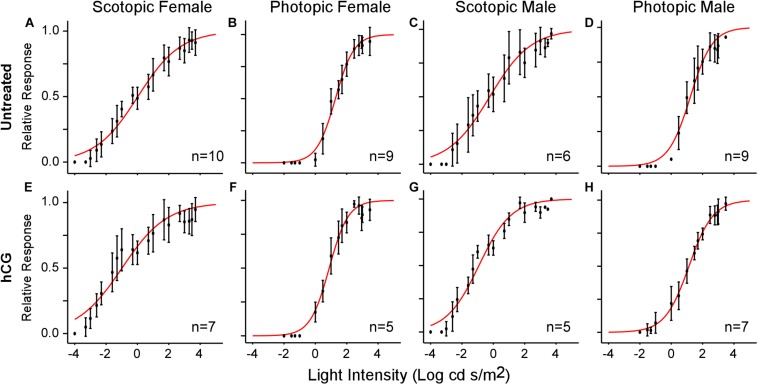
V-Log(I) curves showing mean ERG responses for each sex under scotopic and photopic conditions. Each point represents the mean (±SD) relative b-wave amplitude at each light intensity. Sample size (n) indicates the number of frogs used in each test. (A–D) V-Log(I) curves for untreated frogs. (E–H) V-Log(I) curves for hCG injected frogs. Red curves are the least-squares fit of the Boltzmann function to the entire population data. Note that Boltzmann function fits for each individual response were used to calculate mean threshold (i.e., light level eliciting 10% of maximum b-wave amplitude), slope, and dynamic range.